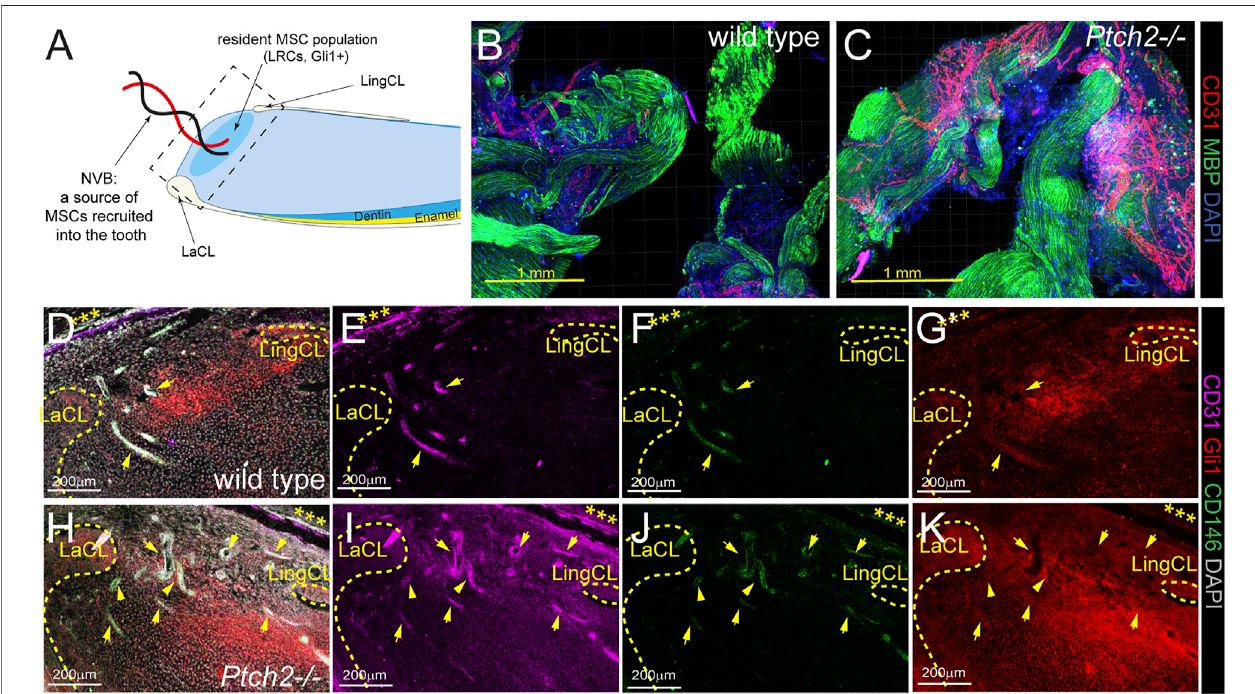
FIGURE 1 | Analysis of SC populations in Ptch2 − / − incisors. (A) Schematic illustration of sagittal section of mouse incisor (LaCL = labial cervical loop, LingCL = lingualcervicalloop).Squarewithdashedlineshowstheareaofsections inD-K. (B,C) ImmunolabelingforCD31(red)and MBP(green)inthewholemountwild-typeand Ptch2 − / − neurovascular bundles. (D – K) Immuno fl uorescence labeling of CD31 (pink), GLI1 (red), and CD146 (green) in frozen sections of the incisor proximal ends isolated from 4-week-old wild-type and Ptch2 − / − animals. Cervical loops are indicated by yellow dashed line. Arrows indicate blood vessels identi fi ed by CD31 staining. Asterisks indicate peripheral nerve. Scale bars: yellow = 1 mm, white = 200 μ m.